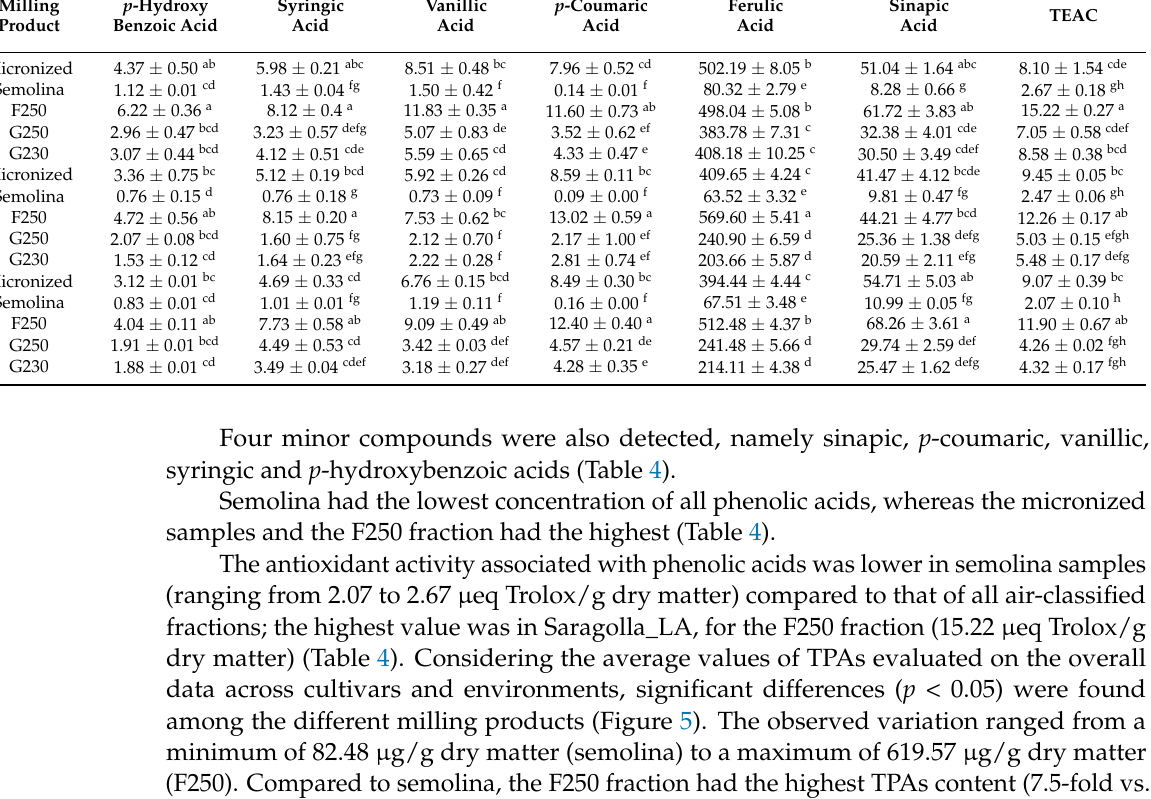
Table 4. Phenolic acid profiles ( µ g/g dry matter) and antioxidant activity ( µ eq Trolox/g dry matter) of micronized samples, air-classified fractions (F250, G250, G230) and semolina obtained from three durum grain samples (Saragolla_LA, Antalis_BA, Antalis_MA). Different letters within columns indicate significant differences ( p < 0.05). Durum